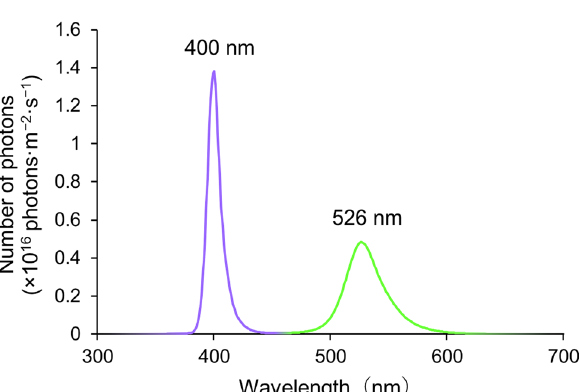
Figure 5. Emission spectra of light source with UV- and green-LEDs. The light source was composed of alternating 42 UV-LEDs and 42 green-LEDs. The intensity of light was measured using a high-speed spectrometer (HSU-100S). An attached sensor fiber was placed 50 cm in front of the light